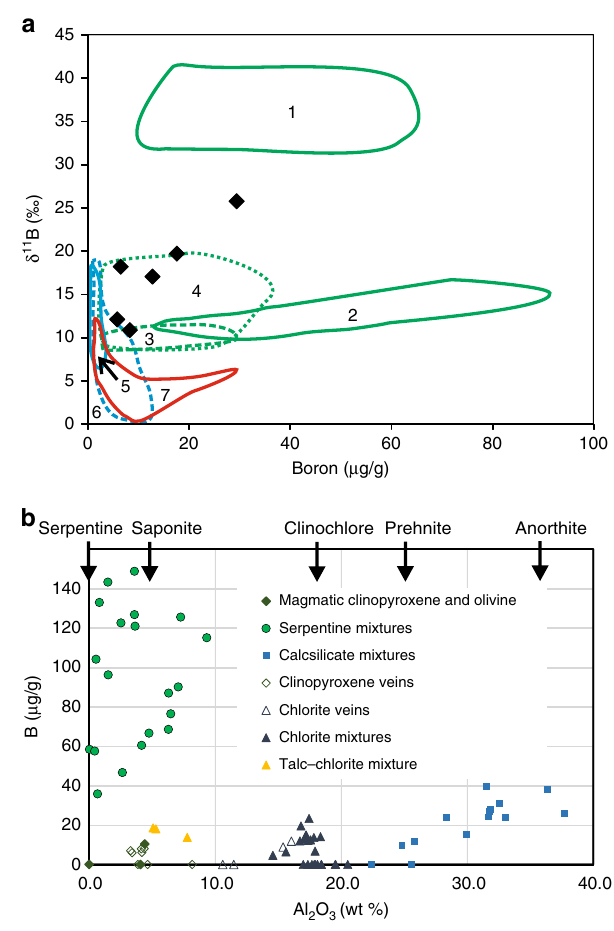
Fig. 3 Whole rock and in situ boron analyses. a New whole rock data (black diamonds) compared with existing datasets: Fields 1 and 2: Atlantic core complex serpentinites 16,17 . Fields 3 and 4: Atlantic core complex talc- altered serpentinites 17,19 . Fields 5, 6 and 7: Oman ophiolite gabbros, dykes and lavas respectively 39 . b LA-ICPMS data for boron and Al 2 O 3, with the Al 2 O 3 content of endmembers indicated. Analytical RSD is 10% at 7 ppm B and 2% at 200 ppm B. However, because of uncertainties in the Si-content (to which data were normalised) of mixed analyses, the majority of the data is semi-quantitative. Calcsilicate mixtures are mainly prehnite, with minor zoisite, epidote, margarite and muscovite, as well as primary plagioclase. For analysis spots see Supplementary Figure 3, and for data